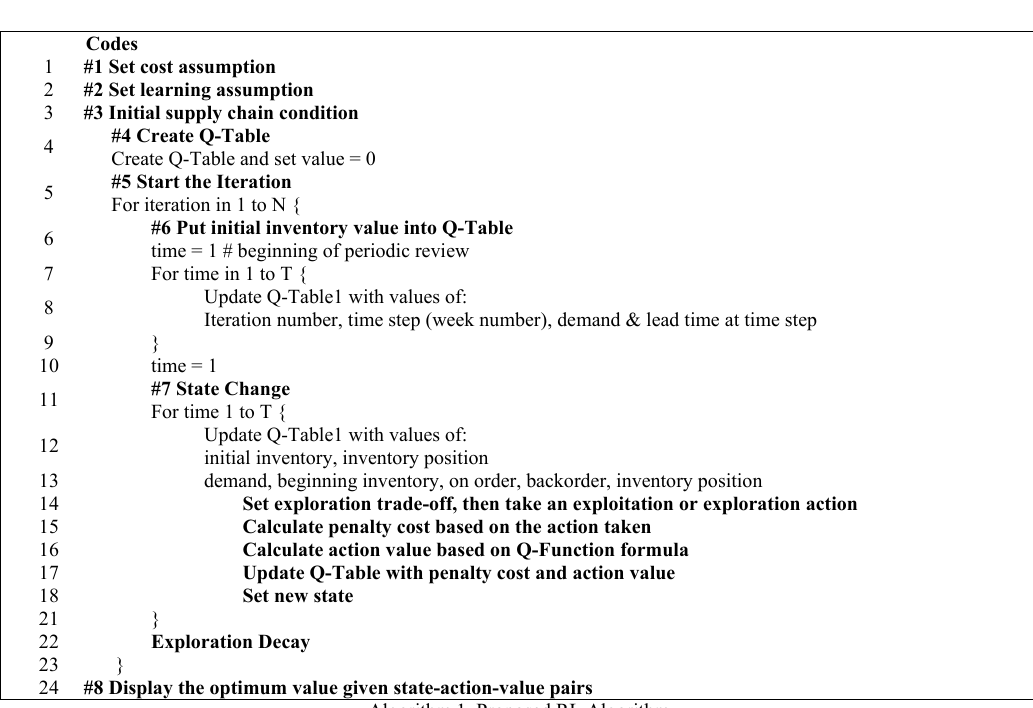
Algorithm 1. Proposed RL